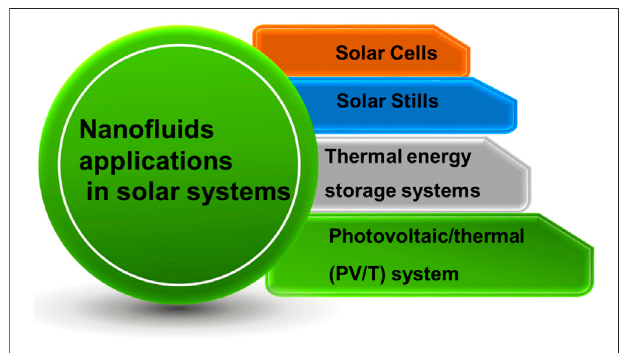
FIGURE 4 | Schematic illustration of applications of hybrid nano fl uids in solar energy